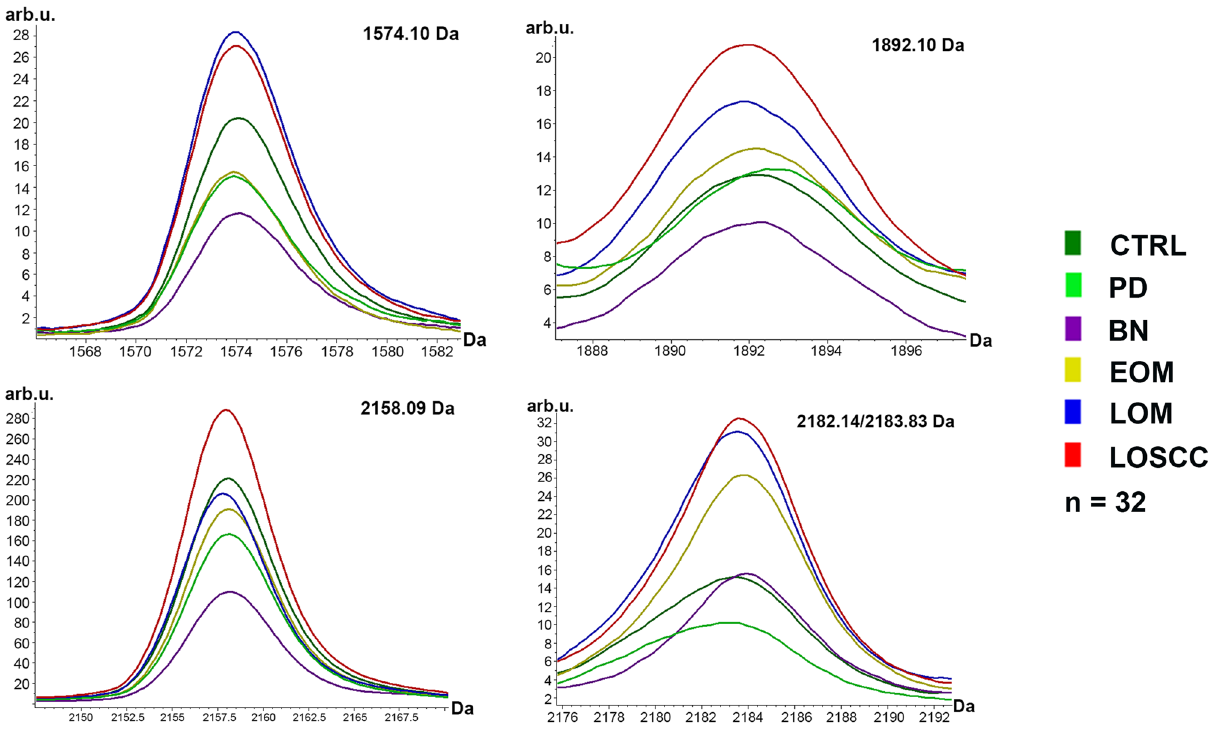
Figure 3. The significantly differentially overexpressed peptides in canine oral cancer groups. Normal (CTRL), periodontitis (PD), benign tumors (BN), early-stage oral melanoma (EOM), late-stage OM (LOM) and late- stage oral squamous cell carcinoma